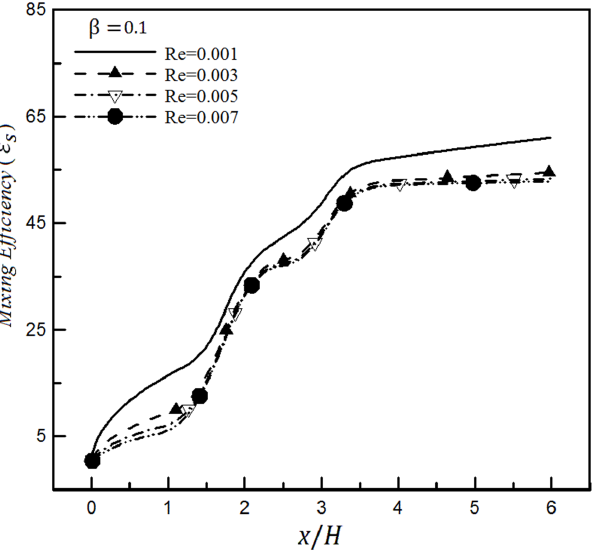
Figure 14. Mixing efficiency changes for a slip coefficient (0.1) and different Reynolds numbers through mixing entropy index.